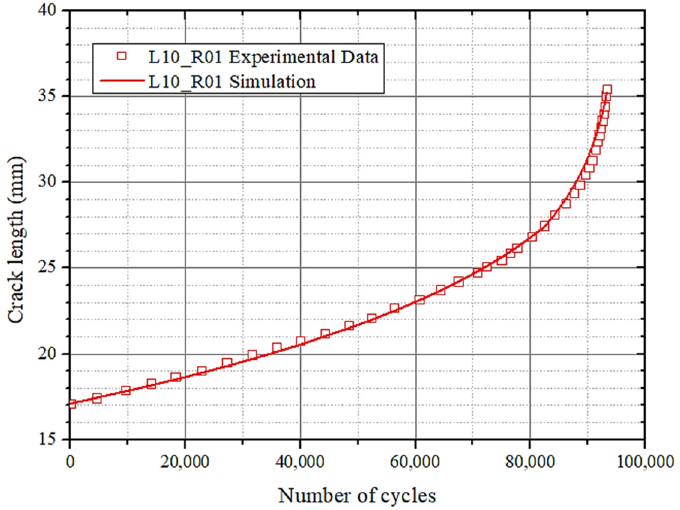
Figure 11. Crack length vs. number of cycles for L10-R01: experimental results and simulation.